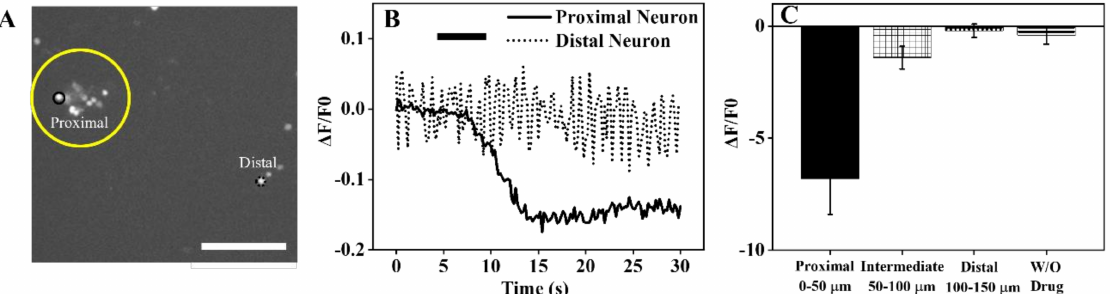
Figure 5. ( A ) Fluorescent calcium imaging of neuron activities upon electrically stimulated GABA released from microwire coated with PEDOT/SNP(GABA). Yellow circle indicates the position of drug releasing site on microwire, black solid circle labels a proximal neuron and dash circle labels a distal neuron, scale bar is 100 µ m. ( B ) Fluorescence intensity changes of the two example neurons shown in ( A ), upon electrically stimulated GABA release, horizontal line indicates the stimulation duration. Image capture rate was 200 ms/frame for 30 s. ( C ) Maximum intensity decrease in neurons averaged from three separate cultures at different distances, as well as the electrical control group where empty PEDOT/SNP electrodes were stimulated. Highest Ca 2+ activity reduction is found in neurons with the first 50 µ m of the releasing site, smaller response in the intermediate zone of 50–100 µ m, and no Ca 2+ change was observed between 100–150 µ m away or without GABA